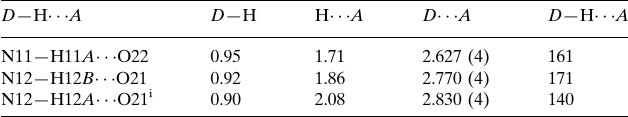
Hydrogen-bond geometry (A˚ , (cid:3)